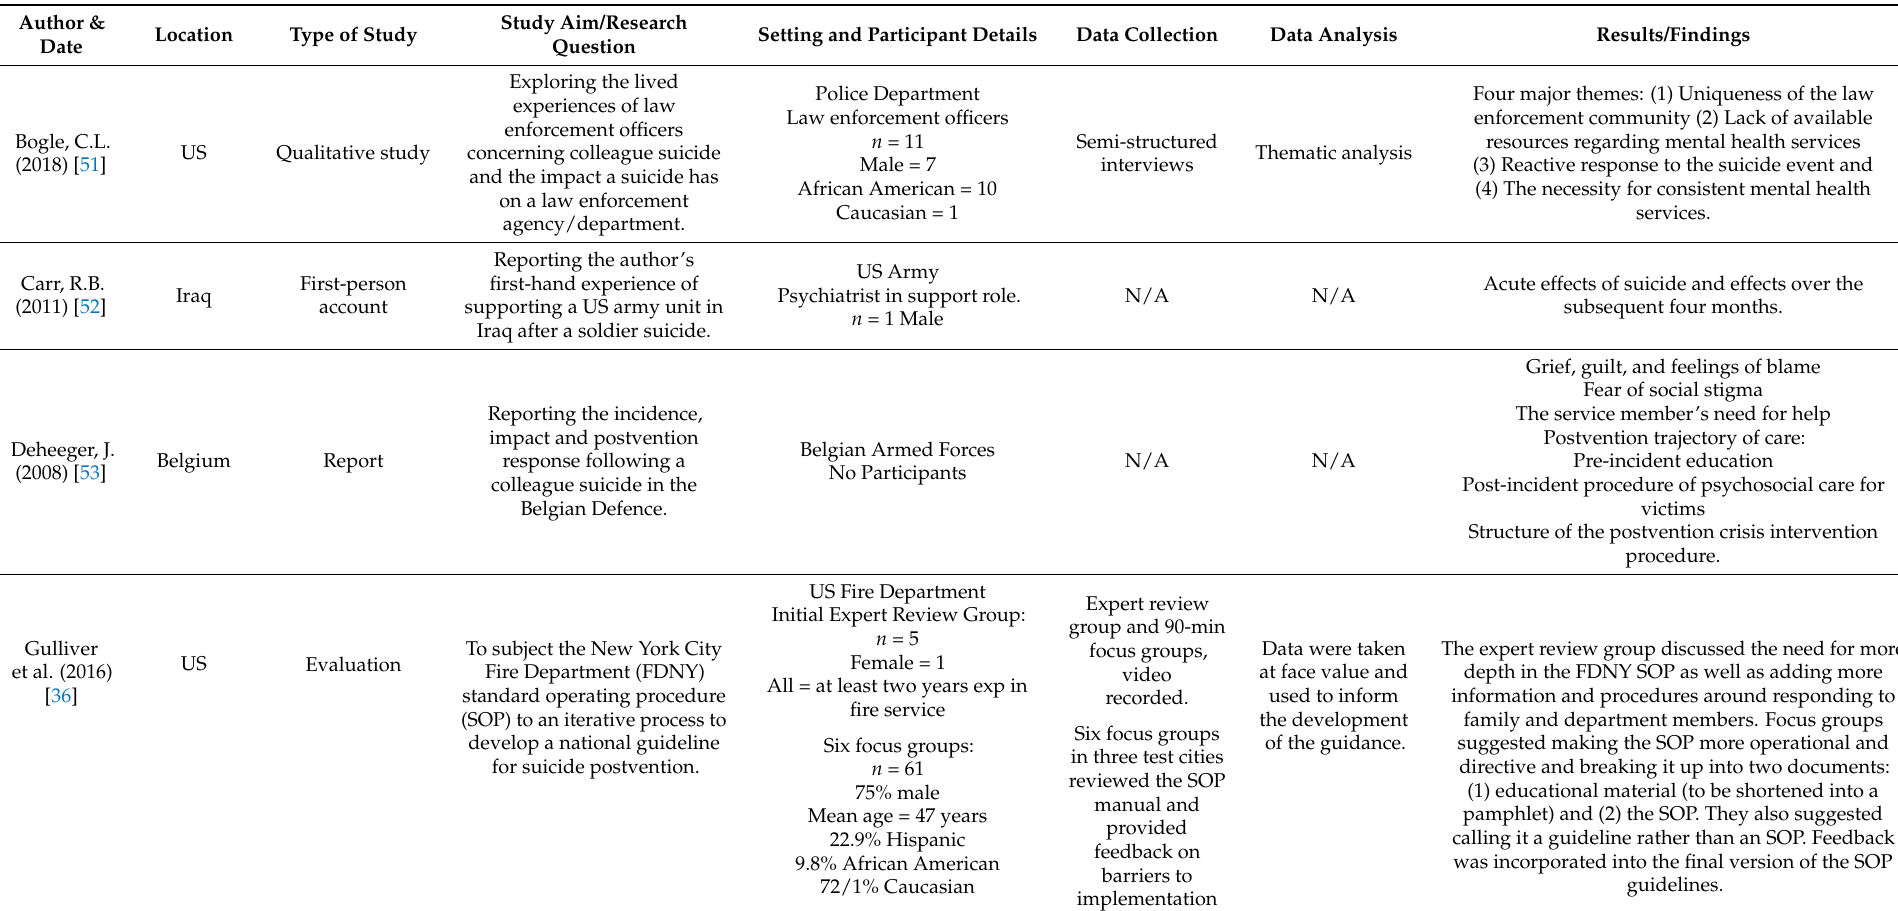
Table 3. Attributes of the included empirical studies, survey studies, case studies, and opinion